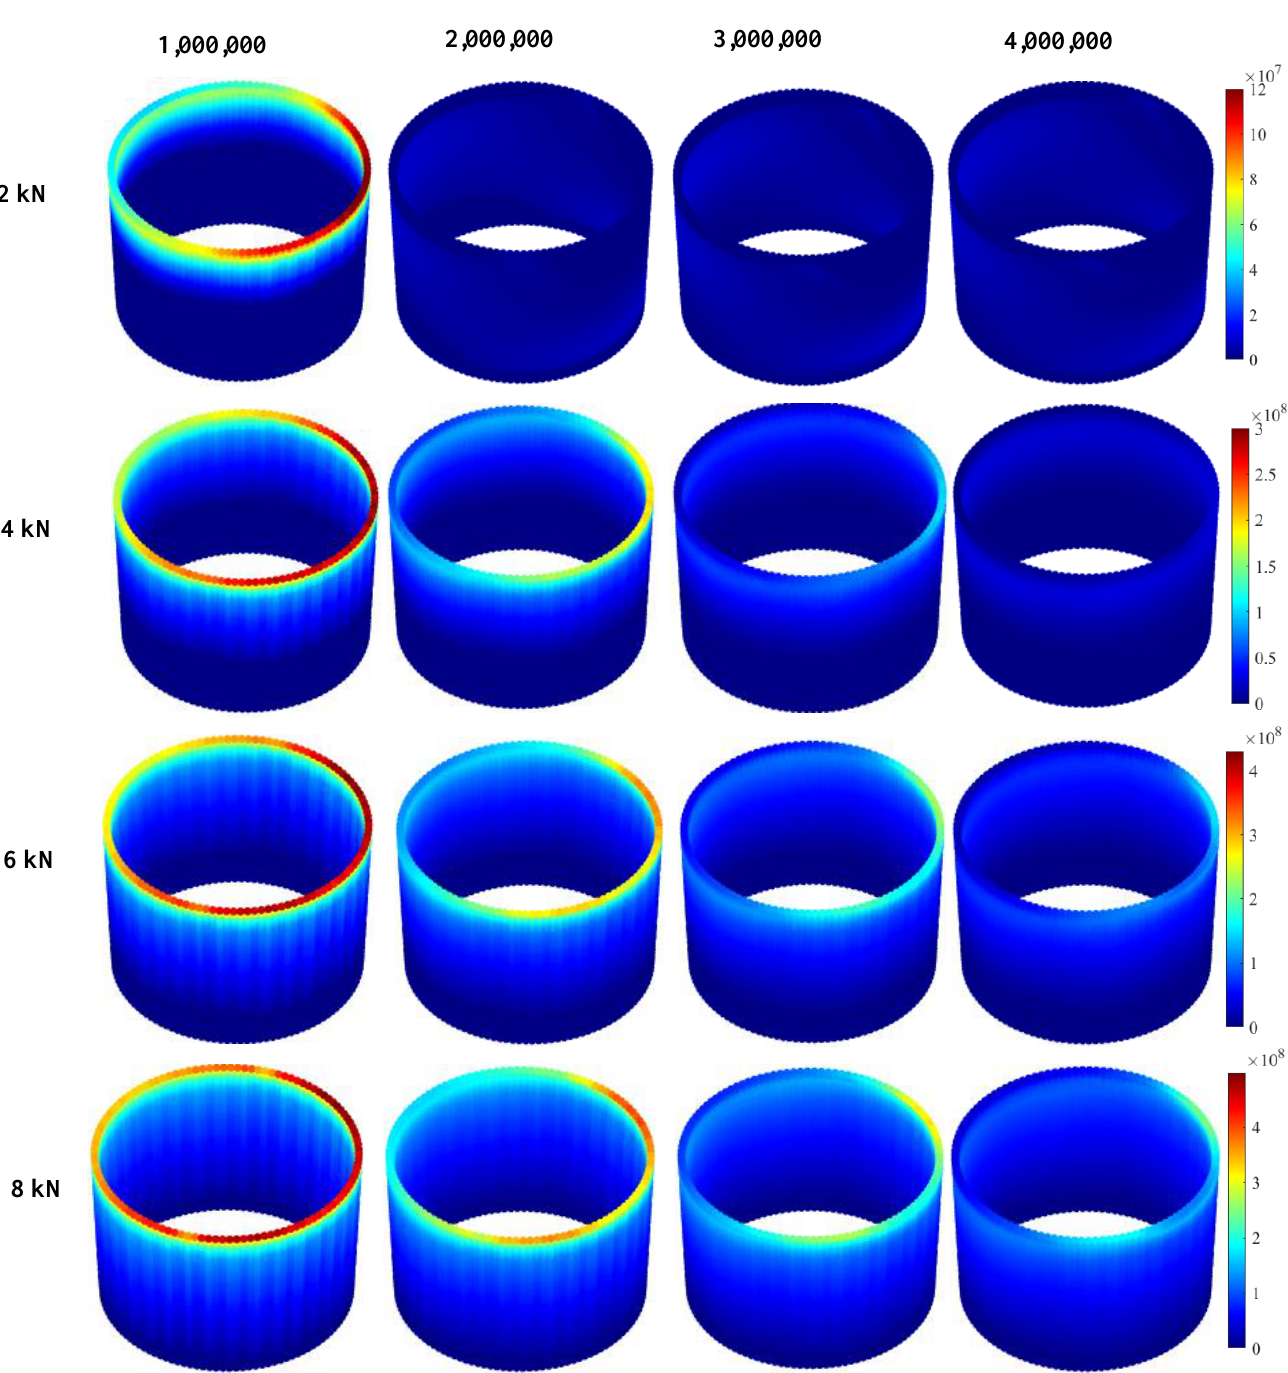
Figure 8. Pressure profiles of the head-neck interface (contact pressures are presented in Pascal).